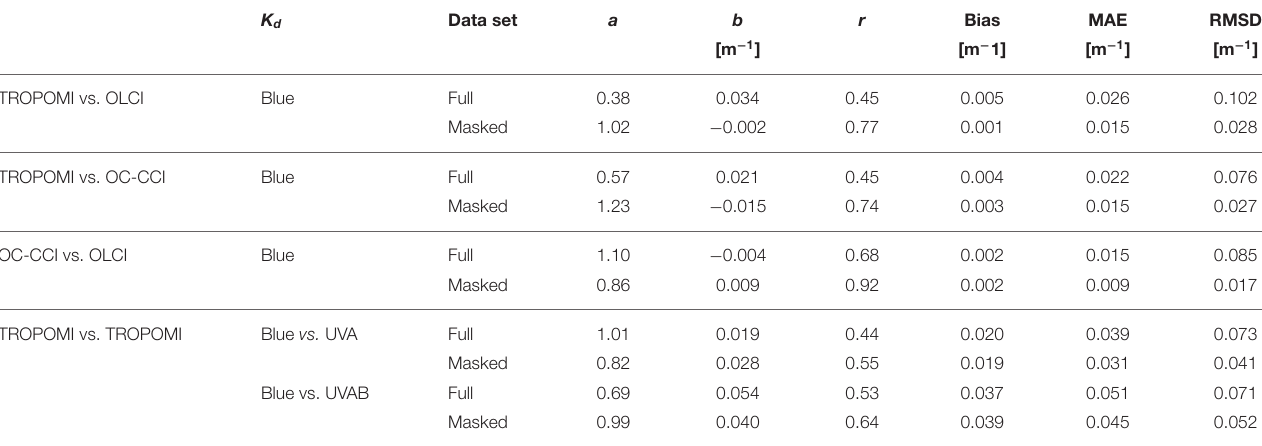
TROPOMI vs. TROPOMI Blue vs.